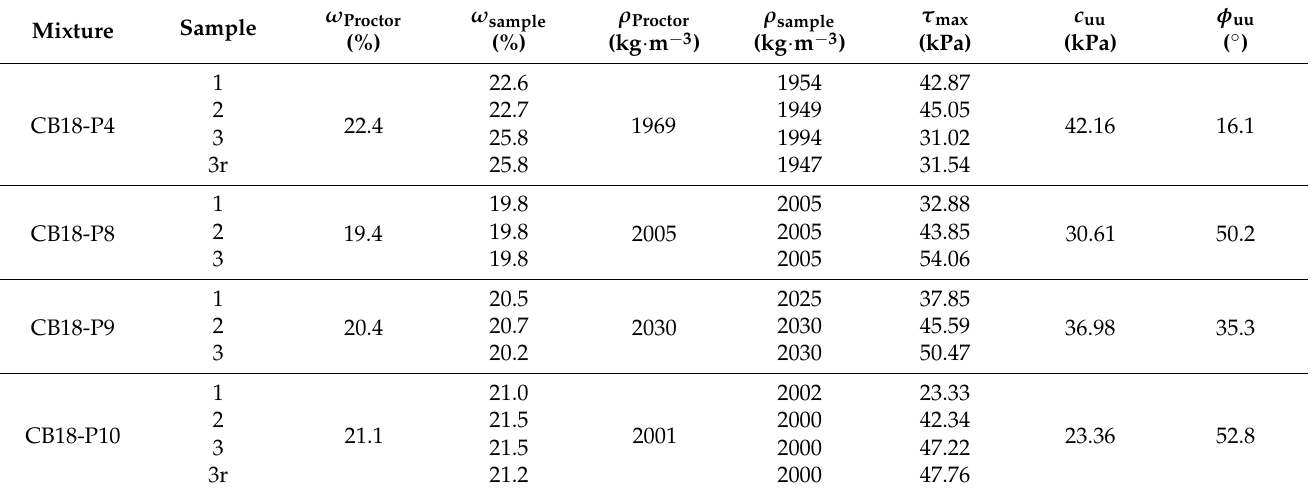
Table 8. Summary of the Undrained Direct Shear Tests. The subscript ‘r’ stands for